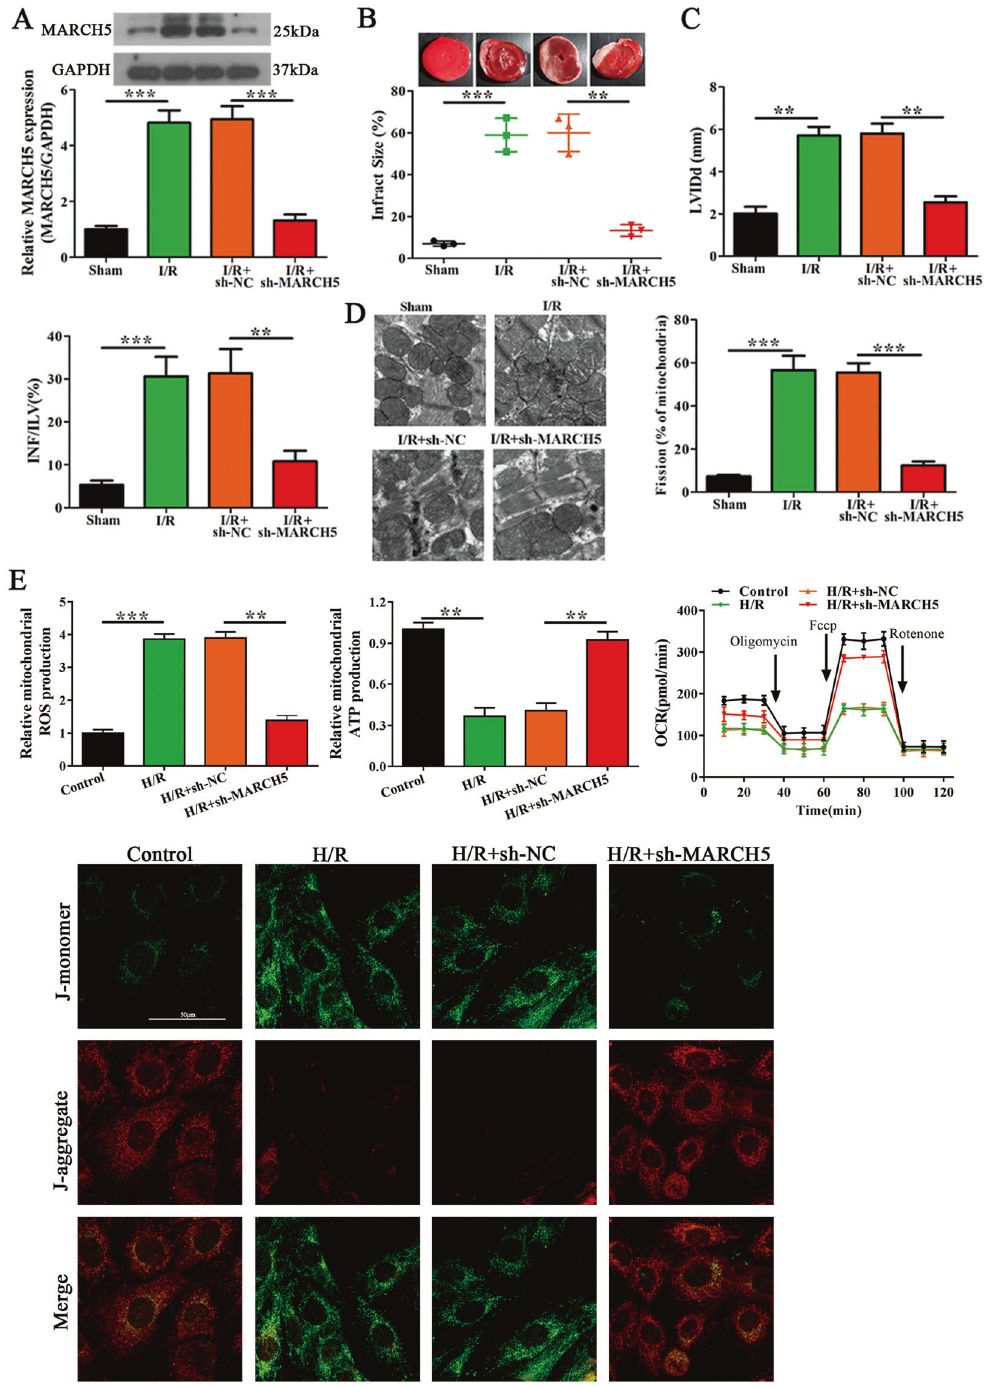
Fig. 7 MARCH5 promotes myocardial ischemia/reperfusion (I/R) injury and regulates mitochondrial fusion and fi ssion in vivo. A The sh- MARCH5 or sh-NC was intraperitoneally administered 24 h before myocardial I/R injury ( n = 6). Post-I/R injury, RNA was isolated and the expression of MARCH5 was determined by qRT-PCR and western blot. B , C The left panel shows representative images of heart tissues. The right panels show the infarct size (%), infarct area/left ventricle (INF/LV) and LVIDd ( n = 6). D Representative TEM images of heart tissues and quanti fi cation of fragmented mitochondria (%) (Scale bar = 0.5 μ m) ( n = 6). E The levels of ROS, ATP and OCR were measured to evaluate mitochondrial function in H/R-treated cardiomyocytes, which were transfected with sh-MARCH5 or sh-NC. JC-1staining (2ug/ml) was used to analyze mitochondrial membrane potential ( △ Ψ m) ( n = 3). ** P < 0.01; *** P < knockdown. On the contrary, the ATP production, OCR and Fig. S10B – E). Moreover, the effect of MARCH5 knockdown on mitochondrial membrane potential ( △ Ψ m) were lower under H/R mitochondrial function experiments was also made. Mitochondrial treatment compared to controls, this reduction was restored by ROS was signi fi cantly increased under H/R treatment compared to MARCH5 knockdown (Fig. 7E). These results indicate that MARCH5 controls, but this promotion was inhibited by MARCH5